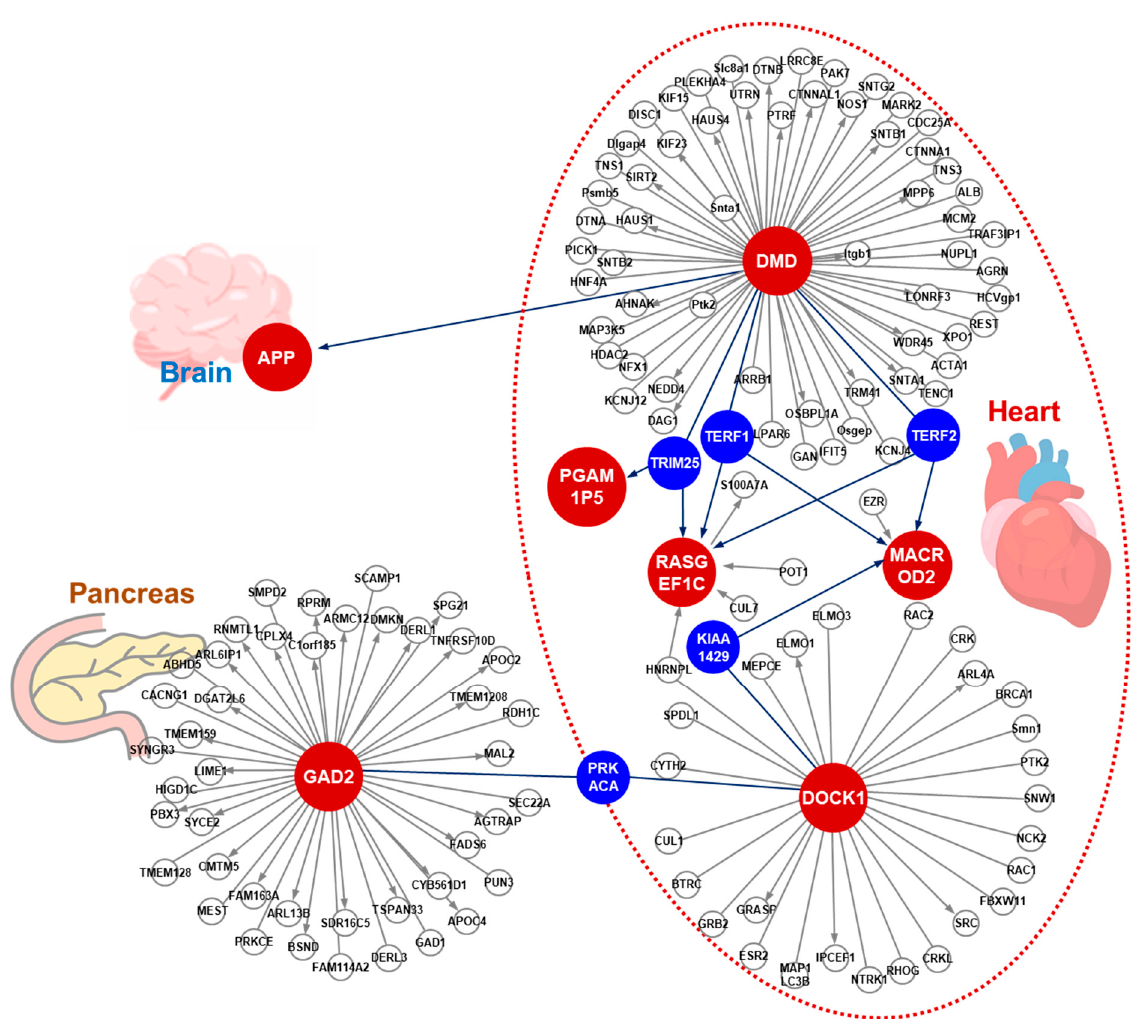
Figure 4. Protein–protein interaction network of the genes containing the AI-assisted identification of SNPs. The protein–protein interaction network was established using the protein-coding genes that contain a SNP. The red dots indicate the genes containing the AI-assisted SNPs and the blue dots indicate the proteins that are connected to the proteins containing SNPs within the network. PGAM1P5 is annotated as a pseudogene. Abbreviations include VIRMA: Vir-like M6A Methyltransferase-associated; PRKACA: protein kinase CAMP-activated catalytic subunit alpha; TERF1: telomeric repeat binding factor 1; TERF2: telomeric repeat binding factor 2; and TRIM25: tripartite motif containing